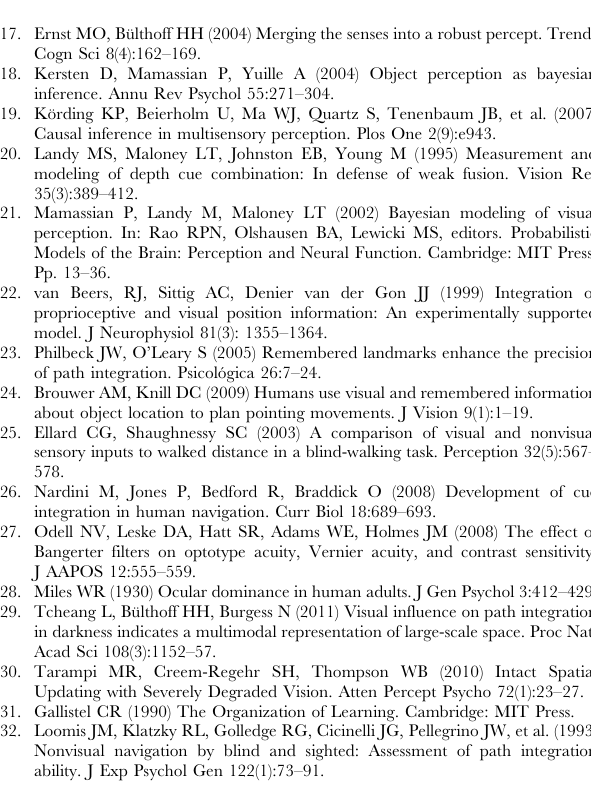
the normal and blurry viewing conditions compiled across participants. Data points marked with an ‘x’ were considered to be outliers according to the robust fits. Figure S2 Remembered landmark estimates with and without a delayed response. Remembered landmark esti- mates in the normal and blurry viewing conditions with and without a delay. Data is compiled across participants. Table S1 Variability of cues and predicted weights. Variability (root mean square errors) and predicted weights of path integration information in the combined cue task computed from the remembered landmark and path integration estimation tasks for both viewing conditions at each of the target